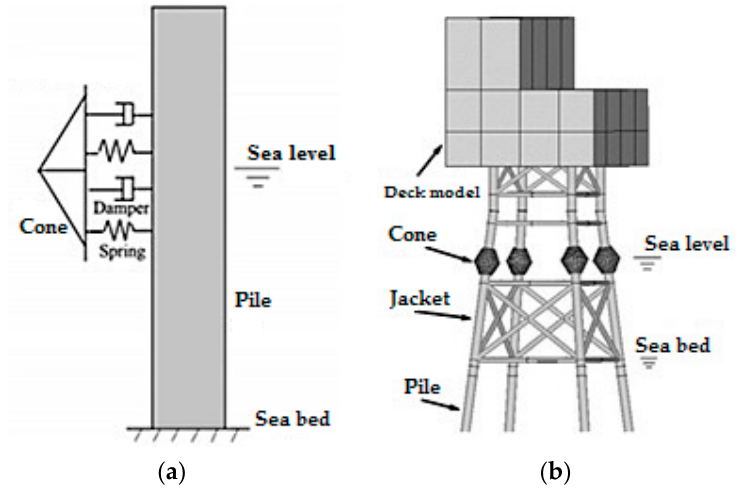
Figure 5. The general scheme of ice-induced vibration reduction by isolation cone system [24]. ( a ) Diagram of isolation cone system, ( b ) Model of the isolation cone system.